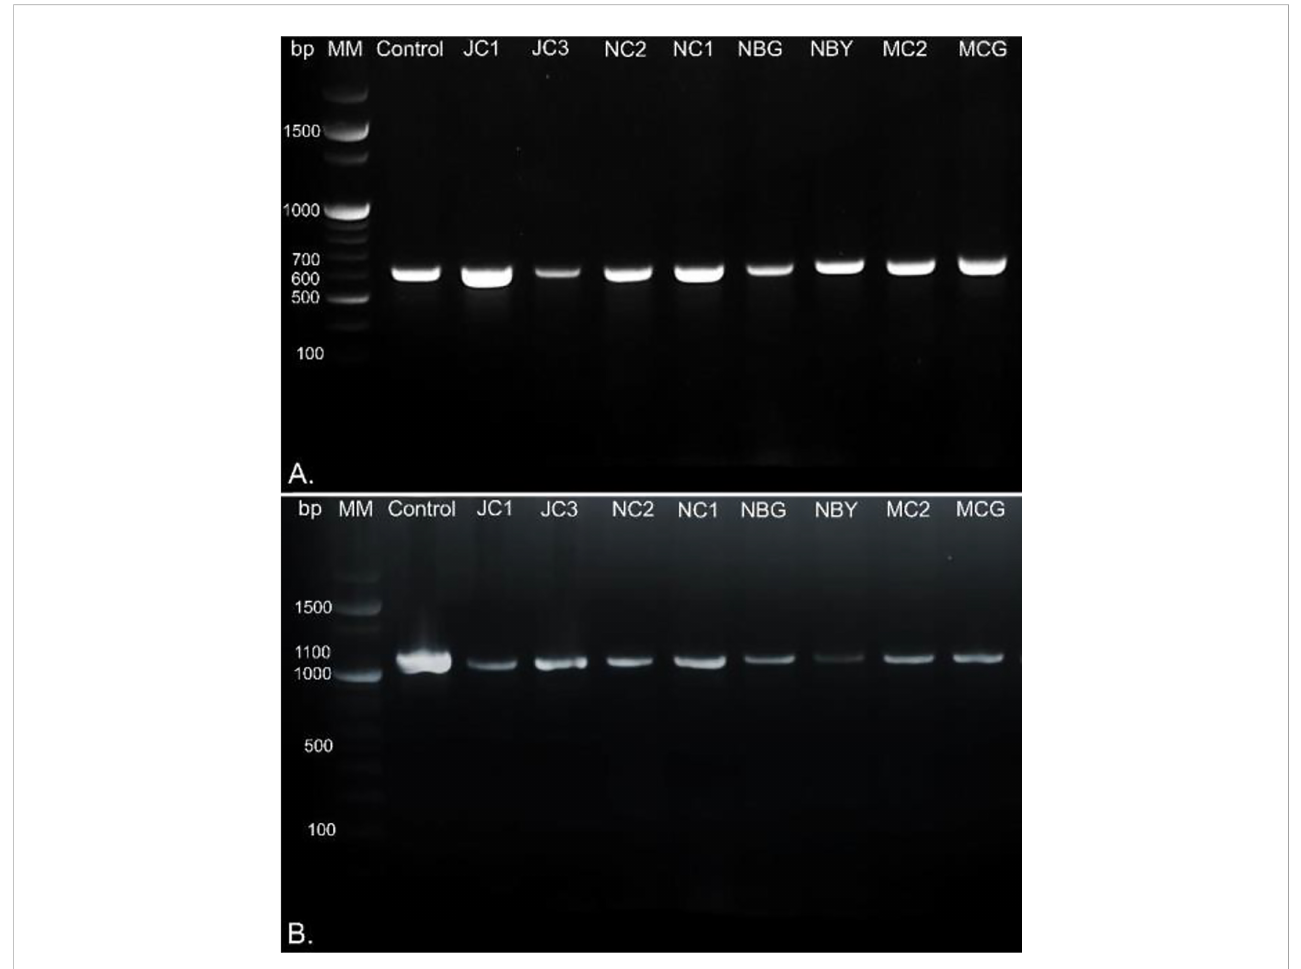
FIGURE 2 DNA gel electrophoresis pro fi le generated by (A) ITS and (B) tef1 a primers with rhizospheric fungal isolates with 100bp marker, MM, Molecular Marker; Control, Positive control; bp, base pairs.